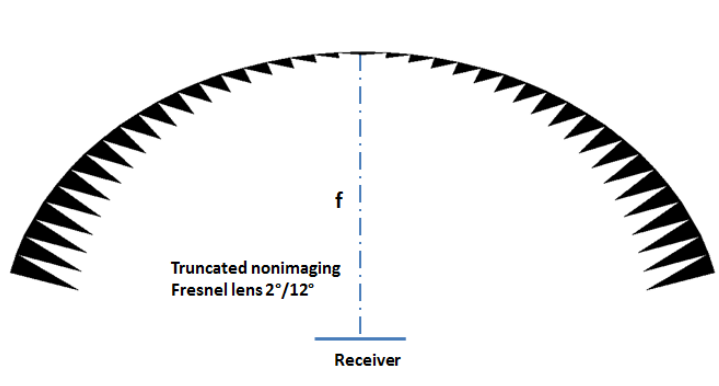
Figure 6. Schematic view of the non-imaging curved Fresnel lens, proposed by Leutz et al. [12].